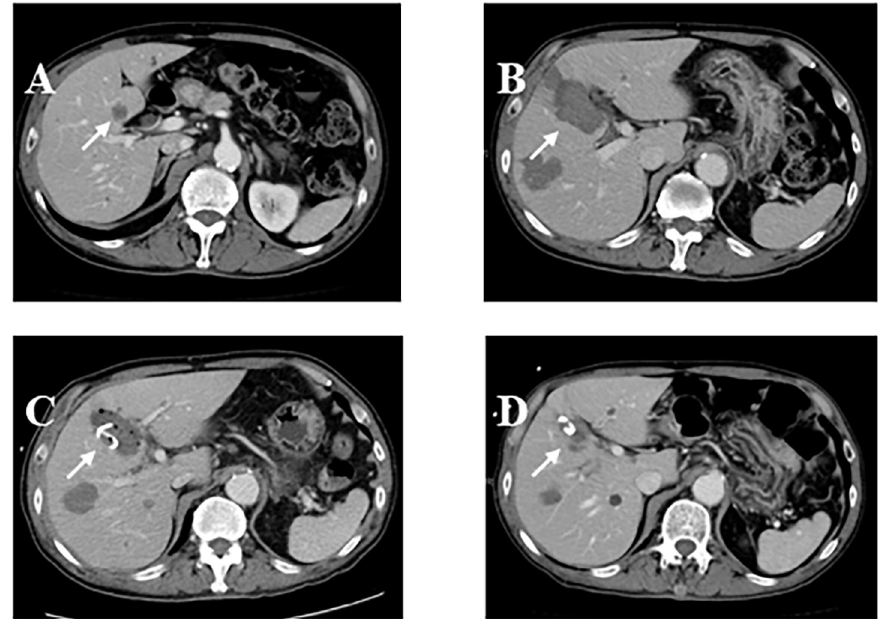
Fig 3. A case with liver abscess following radiofrequency ablation (RFA). A 74-year-old male patient underwent RFA of a metastatic liver tumor secondary to bladder cancer. A: Computed tomography (CT) imaging before RFA showed a 1.2 cm tumor in segment 5 (arrow). B: CT scan after RFA showed complete destruction of the tumor. C: 13 days later, the patient complained of abdominal pain with a fever of 38.5˚C. CT scan revealed liver abscess on the ablated site; percutaneous transhepatic abscess drainage was performed. D: CT scan 50 days after percutaneous drainage showed shrinkage of the abscess cavity.